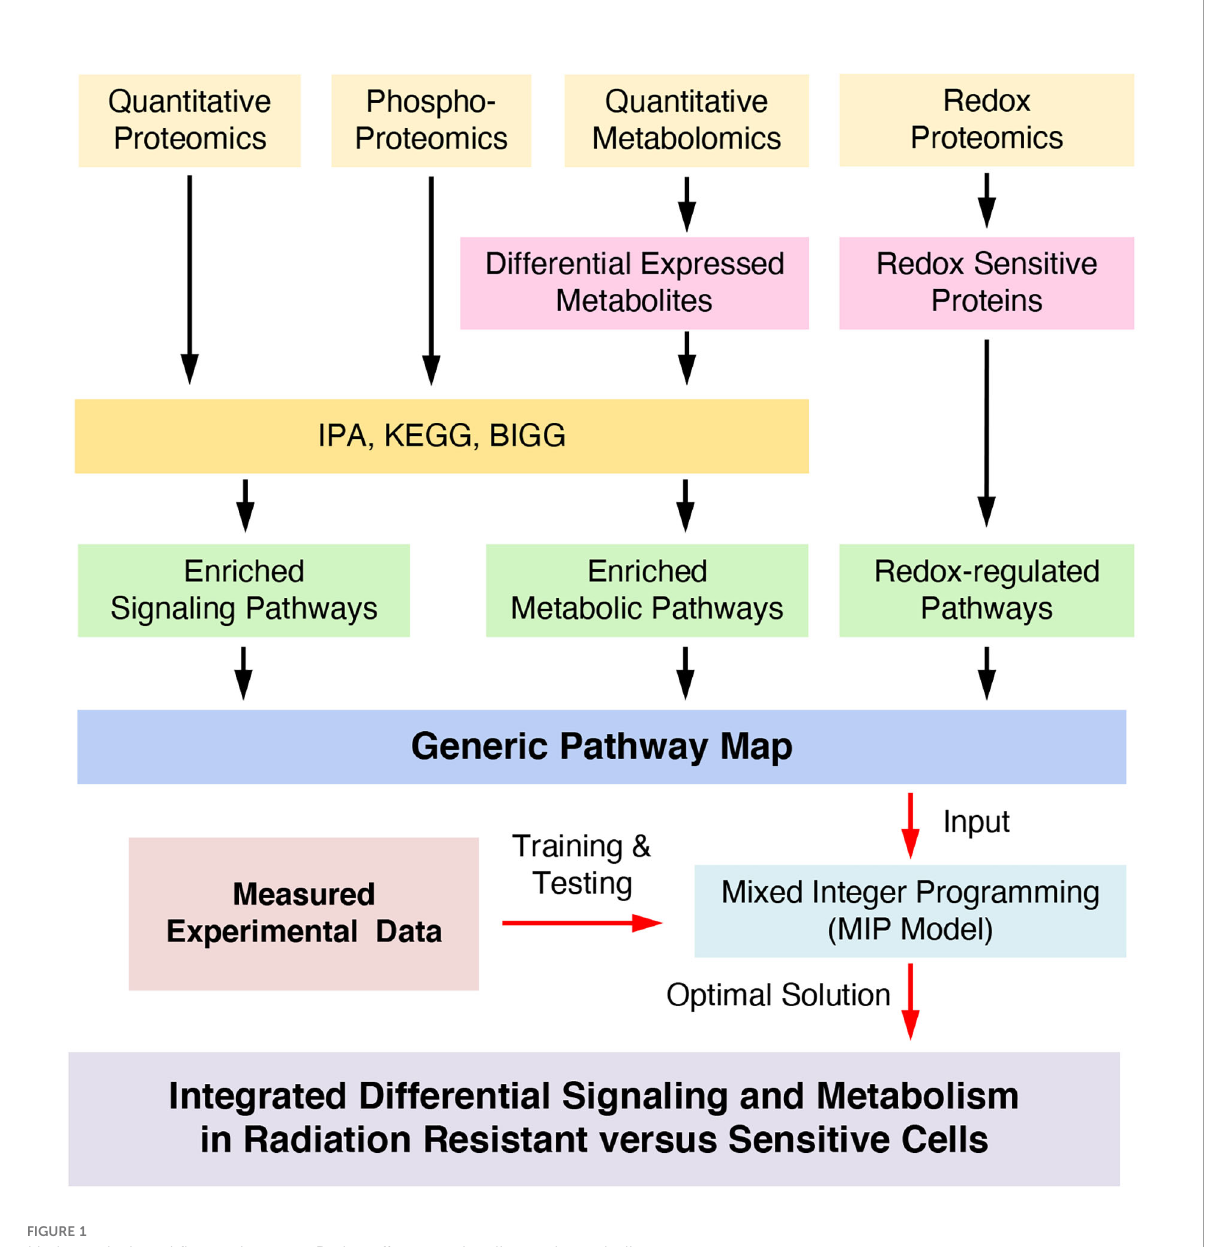
FIGURE 1 Mathematical work fl ow to integrate Redox effects on signaling and